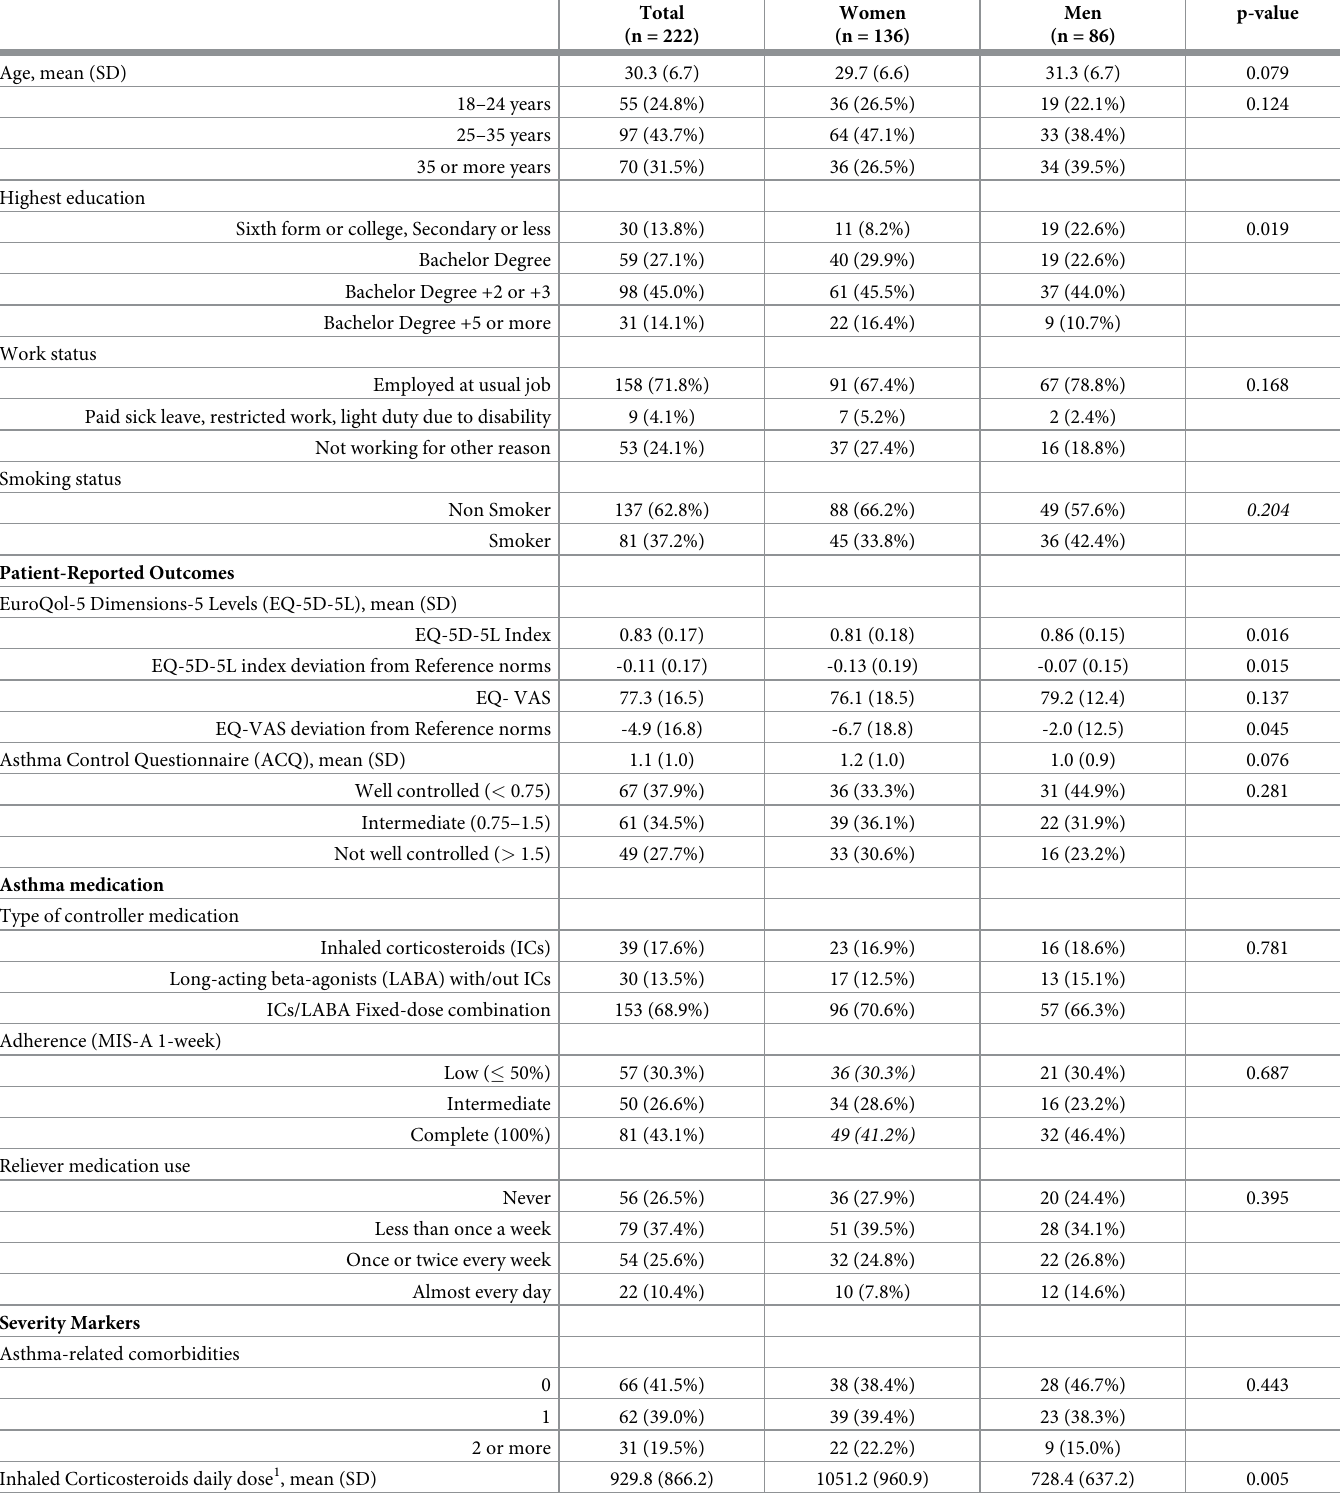
Table 1. Characteristics of study